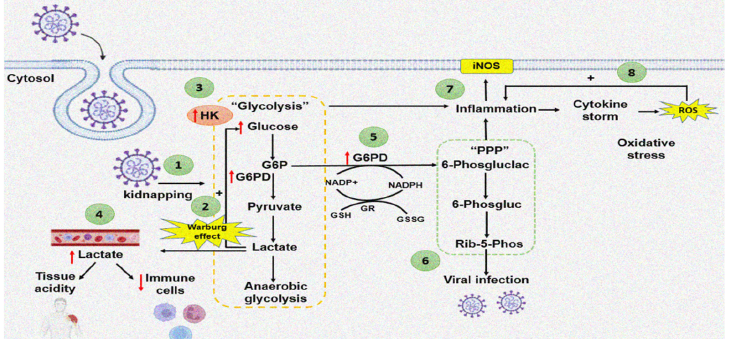
Figure 2. Effect of SARS-CoV-2 infection on G6PD activity. The red arrow up represents increase and down decrease (1) COVID-19 entry and cell sequestration. (2) Increase in lactate stimulates increase in glucose: “Warburg effect”. (3) Increased HK associated with the Warburg effect. (4) Lactate accumulates in the bloodstream, which promotes tissue acidification and depletion of immune system cells. (5) The increase in G6PD provides reducing equivalents for different antioxidant enzymes. (6) Nucleic acids generated by the PPP are used for viral infection. (7) The inflammation stimulates iNOS. (8) Positive feedback between inflammation-cytokine storm-ROS.